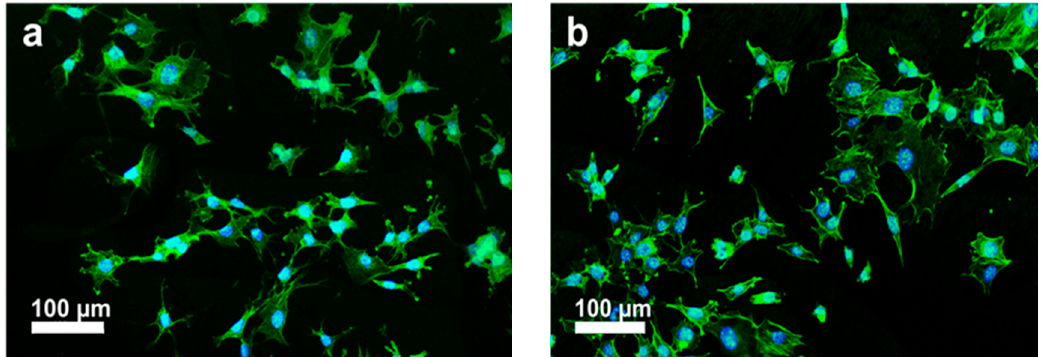
Figure 25. Fluorescence micrographs of murine MC3T3-E1 pre-osteoblasts cultivated on ( a ) PEEK/1.5 wt% MWNT and ( b ) PEEK/3.0 wt% MWNT nanocomposites for 3 days, and stained with F-actin cytoskeleton (green) and nucleus (blue). Reproduced from [63] with permission of MDPI.